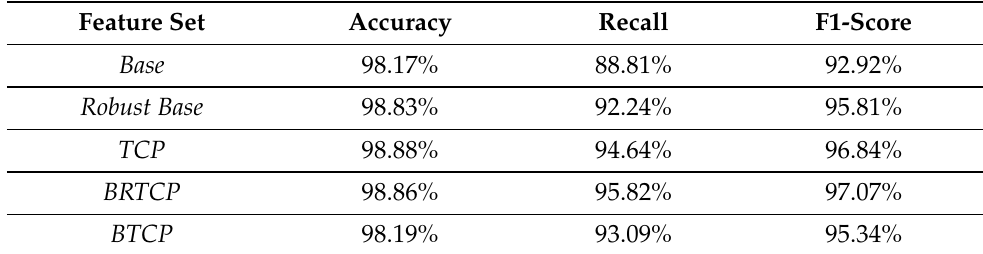
Table 6. Model performance—ELM.